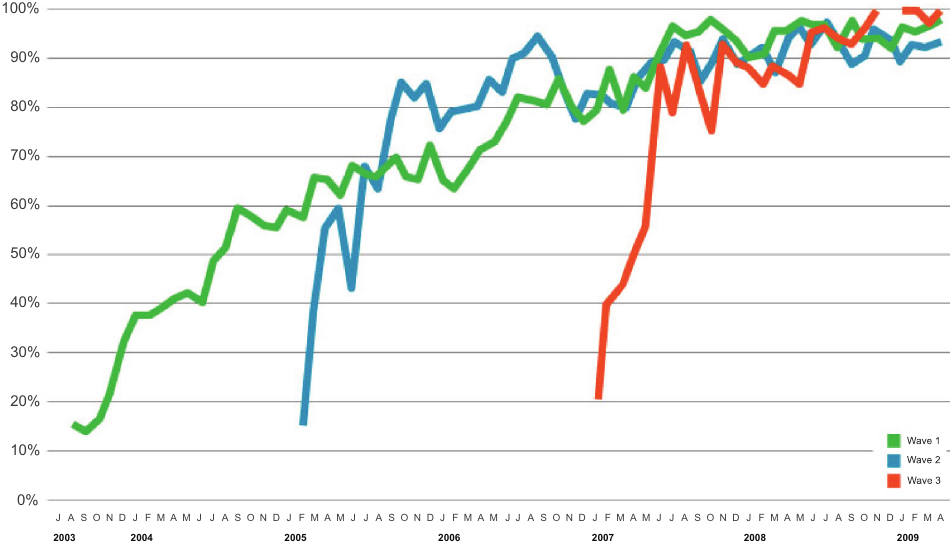
Figure 8. Ecuador: compliance with Active Management of the Third Stage of Labor (AMTSL). The rate of adoption of compliance with AMTSL was much faster in wave 2 and 3 than in wave 1.